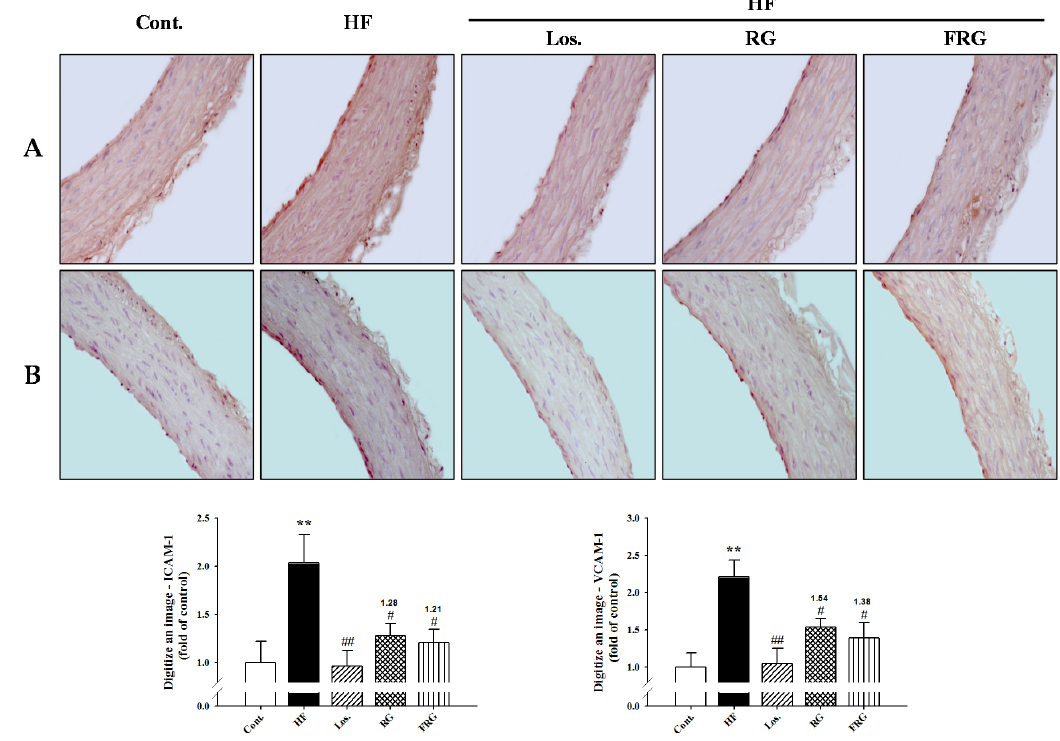
Figure 5. Effects of FRG on ICAM-1 ( A ) and VCAM-1 ( B ) immunoreactivity in aortic tissues of HF diet rats. Representative immunohistochemistry and quantifications are shown (magnification ×400. Values were expressed as mean ± S.E. ( n = 3). ** p < 0.01 versus Cont.; # p < 0.05, ## p < 0.01 versus HF.